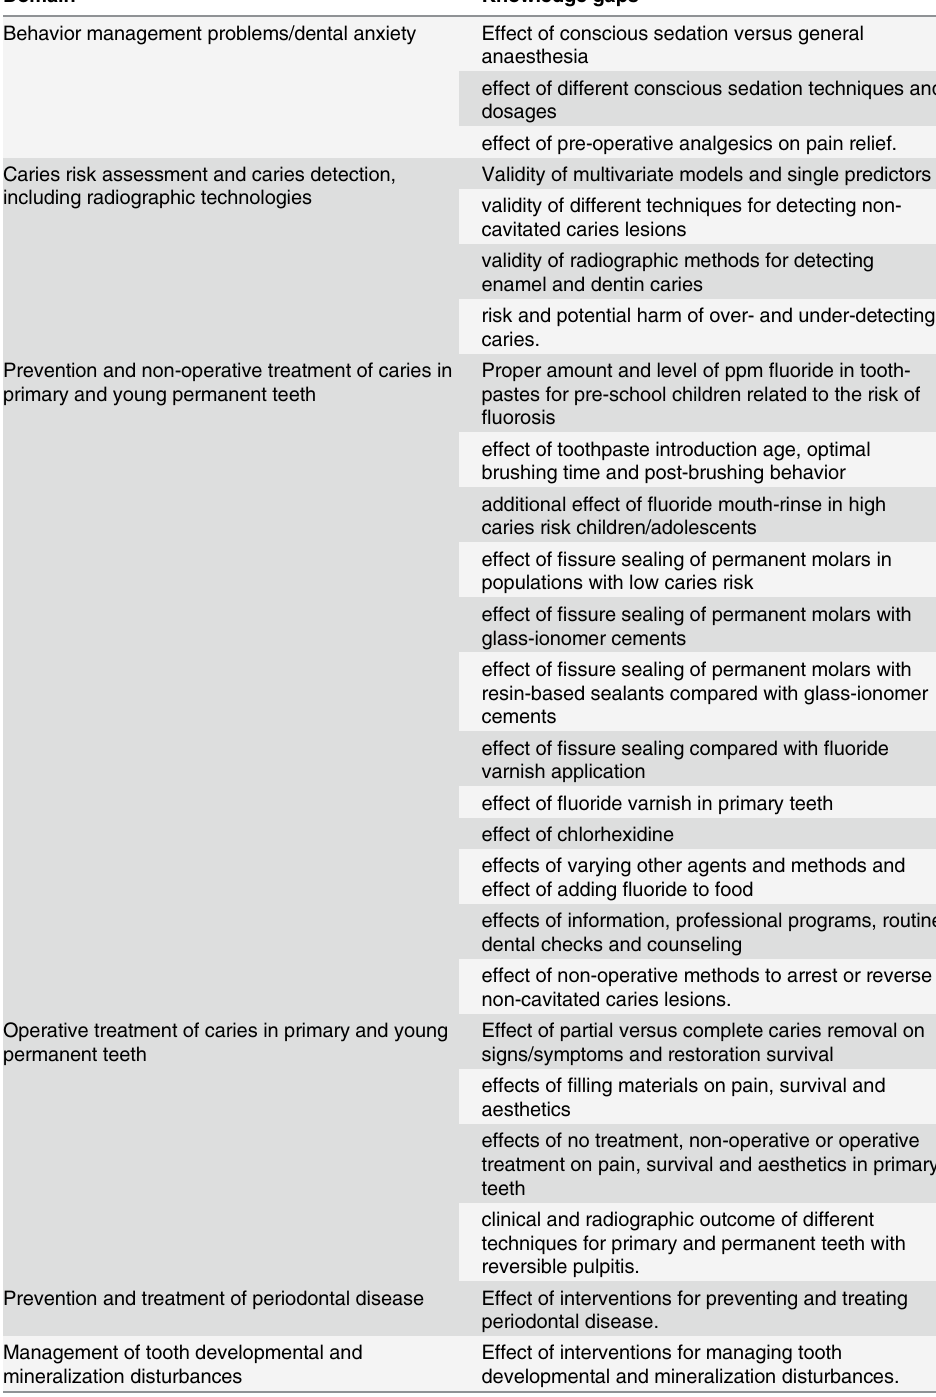
Table 7. Knowledge gaps identi fi ed from the systematic